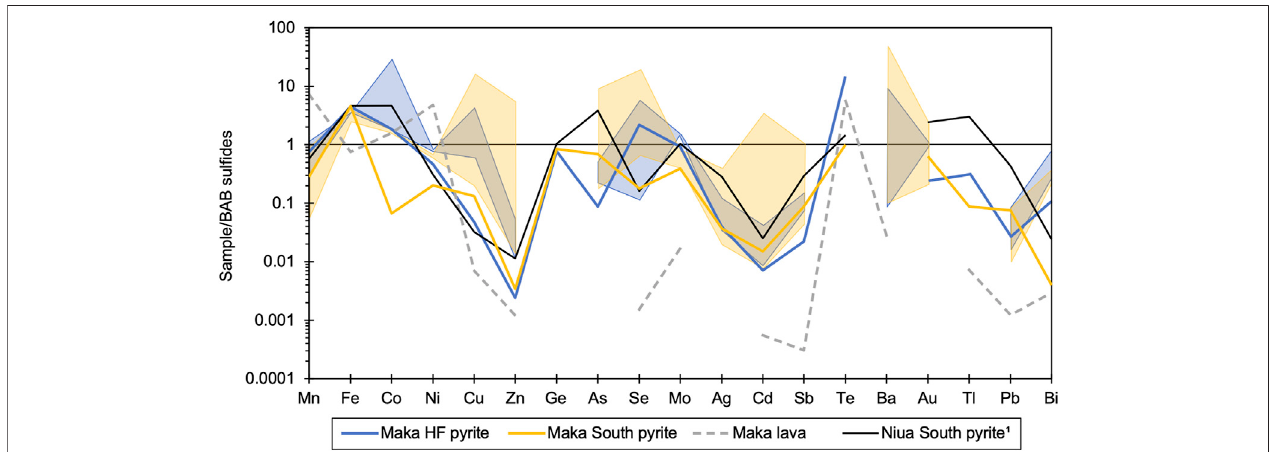
FIGURE 3 | Multi-element diagram comparing the composition of the bulk sulphide-sulphate data from Maka HF and Maka South with the volcanic host rocks, as well as with pyrite from the two vent sites at Maka and from Niua South (Falkenberg et al., 2021). The presented data is normalised to the average bulk composition of back-arc sulphide-sulphate samples ( Supplementary Table S9